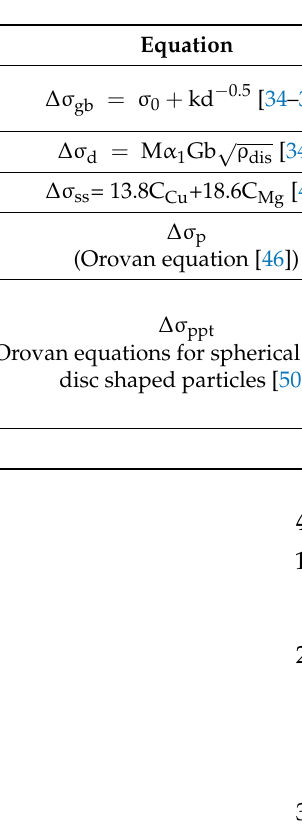
Figure 7. Typical tensile curves of the AlCuYbMg and AlCuGdMg alloys at different temperatures. The contributions from different structure parts are summarized in Table 5. The volume fraction of the precipitates was calculated from the Al-Zr, Al-Yb, Al-Gd, Al-Cu-Mg and Al-Cu-Mg-Mn phase diagrams. The main strengthening effects of 54–60 MPa and 138–153 MPa were achieved from L1 2 and S’ precipitates, respectively. The calculated σ y values are consistent with the experimental value of YS (Table 4). Table 5. Calculated contribution from different structure